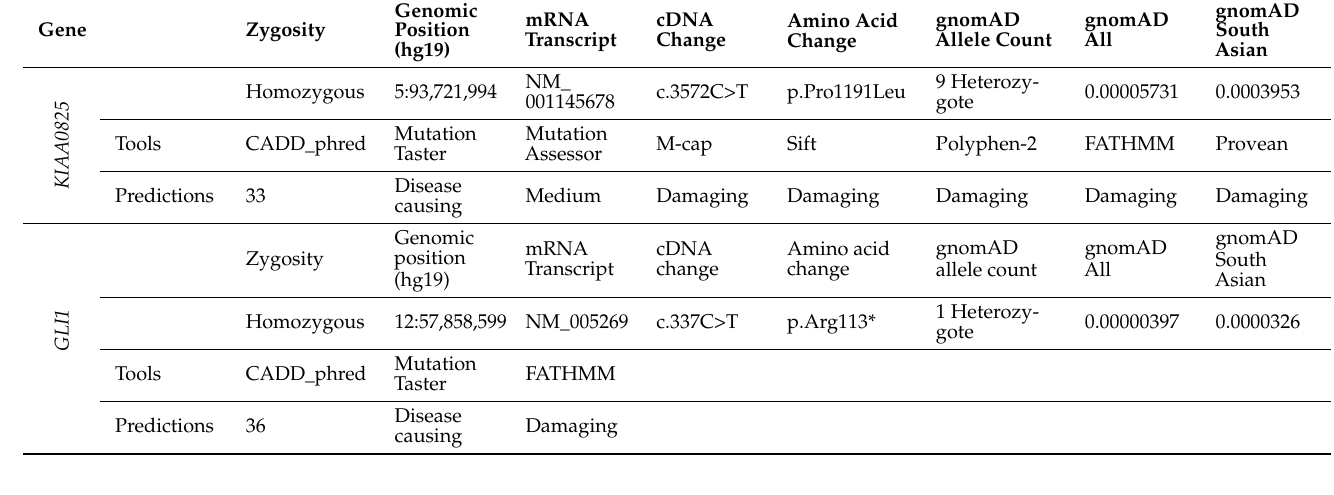
Table 2. Detail of the variants and in silico pathogenicity predictions.